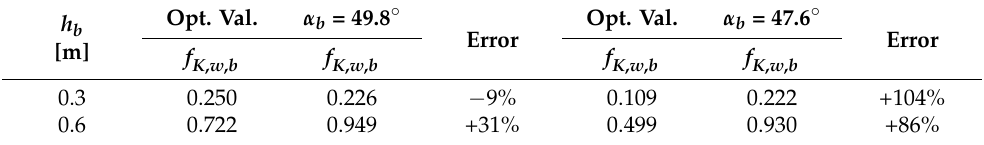
Table 5. Value of f K , w , b [m] and respective error, optimum values from Table 2. Opt. Val. α b = 49.8 h b [m]